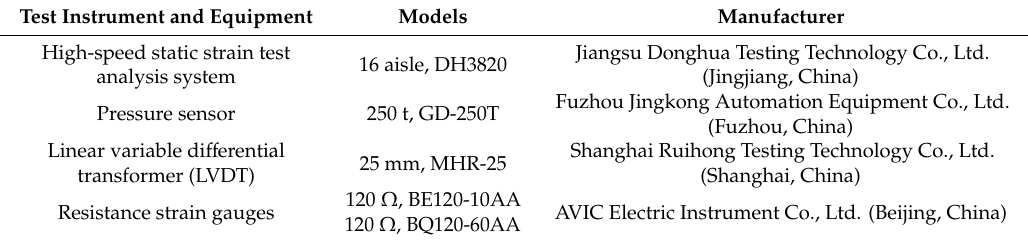
Table 5. Experimental instruments and equipment used to test the shear capacity of RC beams.